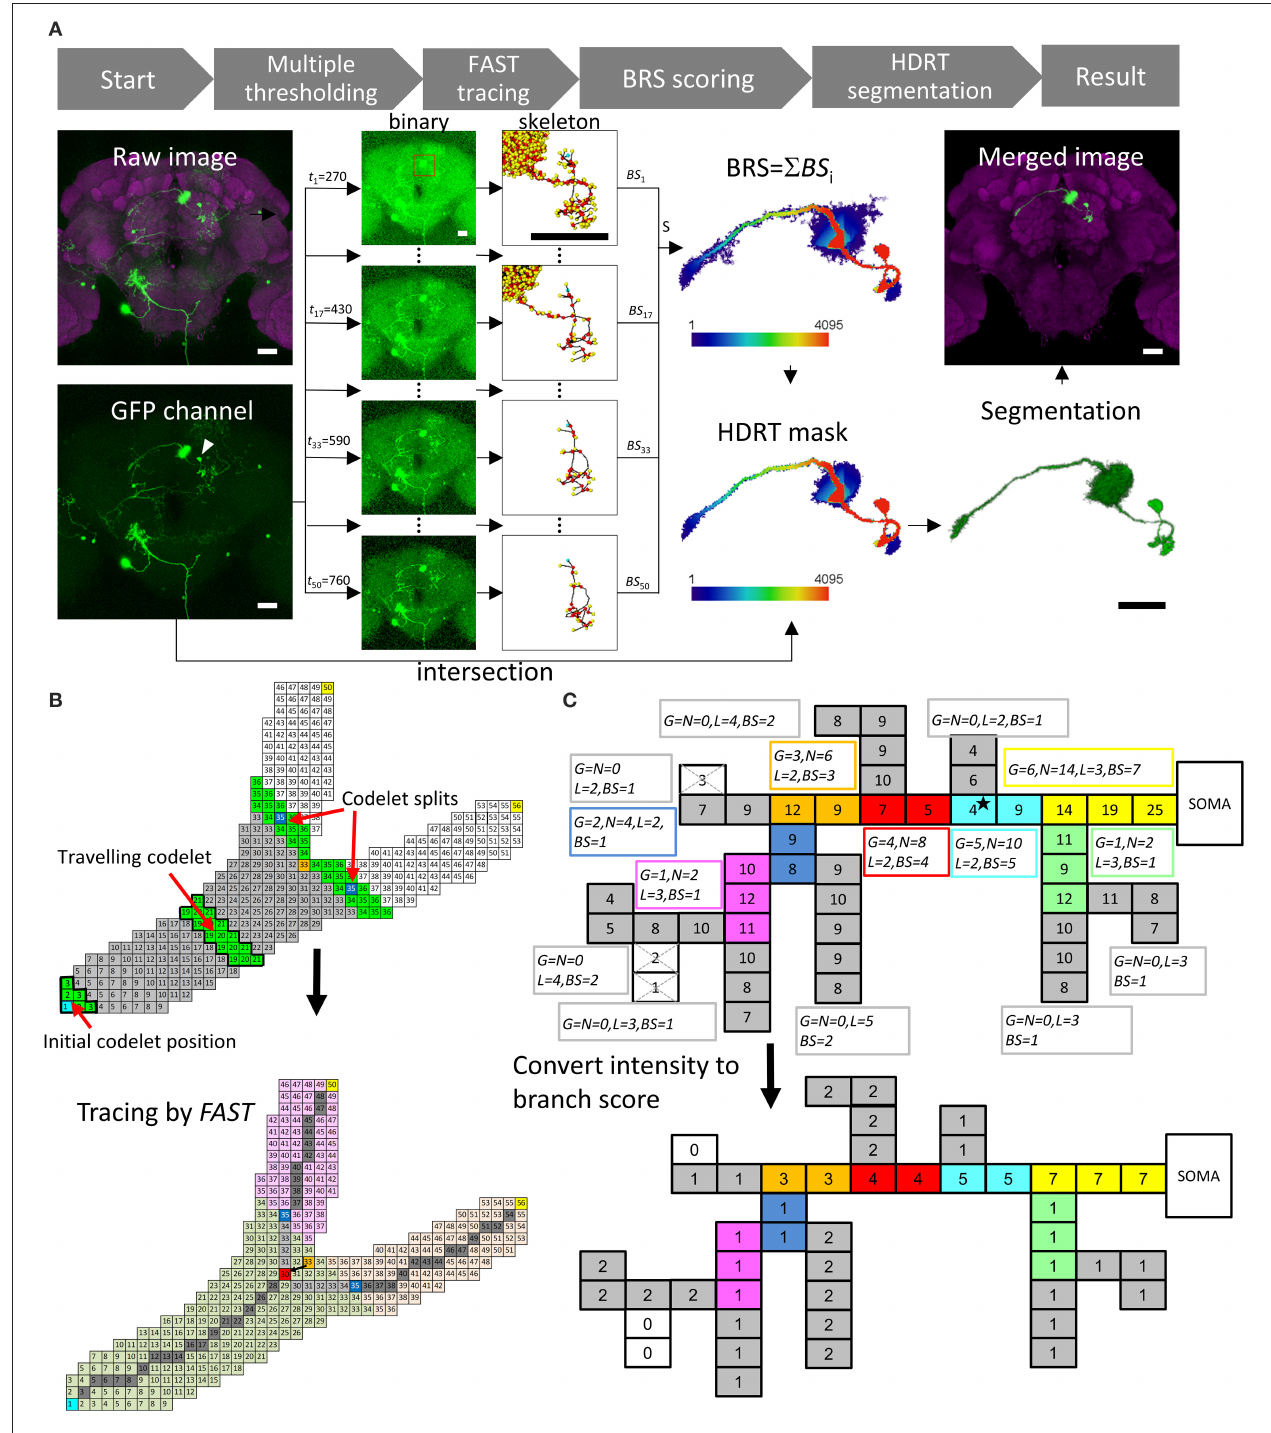
: FIGURE 1 | NeuroRetriever segmentation procedure. (A) NR workflow. Left to right: MARCM-labeled neurons (green) in the whole brain (magenta) 50 datasets : : ( t 1 - t 50 ) with serial intensity thresholds from low (top) to high (bottom) Apply FAST to trace skeletal structure for each dataset and calculate BS Sum 50 BS : : datasets to obtain BRS for each voxel Set BRS threshold to generate HDR thresholding mask Intersect HDR thresholding mask with raw image to segment single-neuron image, and integrate segmented neuron back into original sample brain. (B) Schematic of FAST algorithm. Upper: Numbered source field for each voxel (square), starting with soma (cyan) as 1. Codelet (green), comprising three rows of linked voxels with consecutive source field values, propagates from soma to fiber terminals. Initial codelet (voxels with source field 1, 2, and 3) travels along the branch, and splits into two at branch point (orange, source field = 33). Each branch has (Continued)